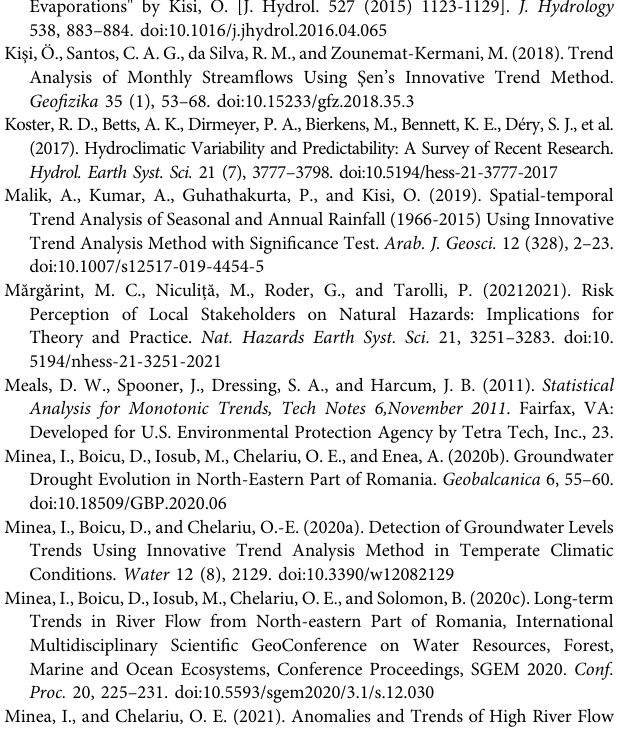
Table Depth. Science 339 (6122), 940 – 943. doi:10.1126/science.1229881 Firat, M., Dikbas, F., Koc, A. C., and Gungor, M. (2012). Analysis of